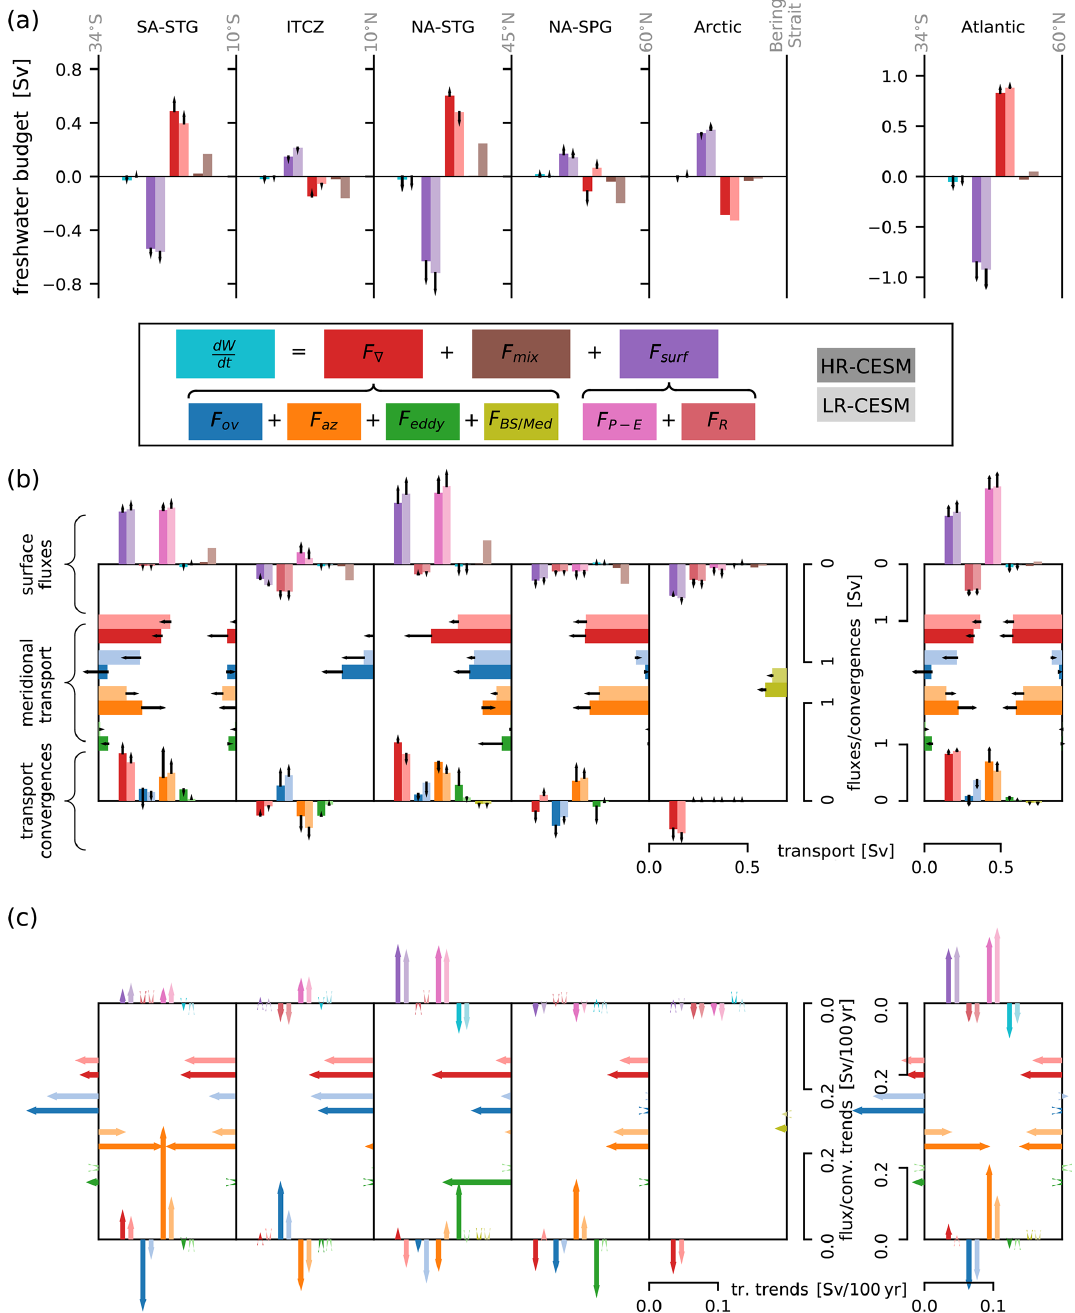
Figure 9. Integrated freshwater budget (Eq. 1) for different zonal bands of the Atlantic. The boundary latitudes (gray) are shown in Fig. 1. Bars are the CTRL simulation averages, and arrows indicate the linear change in the year 2100 of the RCP simulations. Panel (a) summarizes the freshwater budget for the regions with the terms of Eq. (1) with darker (lighter) colors representing HR-CESM (LR-CESM). The notation is explained in Appendix B, and (cid:49)W is the change in freshwater content over 30 years of the CTRL simulations and 100 years of the RCP simulations. Panel (b) shows the freshwater budget terms in detail, where the horizontal bars represent the advective transport across the meridional boundaries with their convergence indicated by the vertical bars at the bottom. Additionally, inflows from the Bering Strait and the Mediterranean are shown. The bars at the top represent surface fluxes, the freshwater content change over time, as well as the mixing term, and all bars are oriented such that inward-pointing bars indicate addition of freshwater. Note that the vertical scale of the top and bottom bars is identical (if reversed), but the horizontal scale is different, as are the scales for the individual regions and the whole